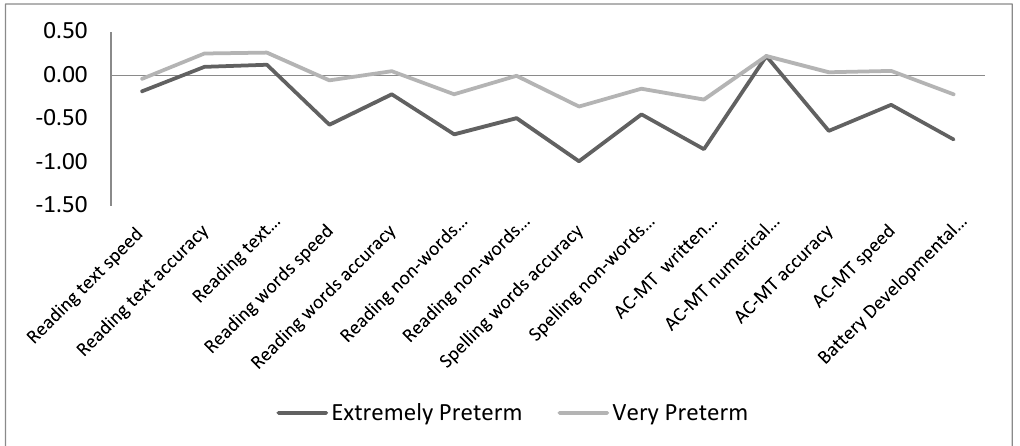
Figure 1. Learning profiles for the extremely preterm and very preterm children.